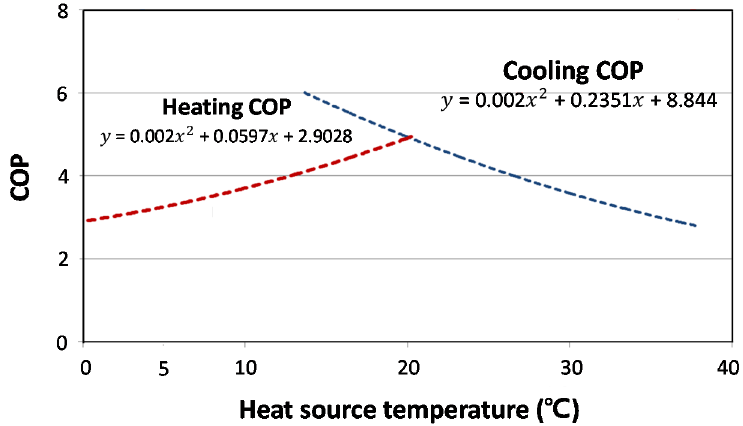
Figure 4. Performance curve of heat pump. Reproduced with permission of [21]. Copyright Elsevier, 2008.